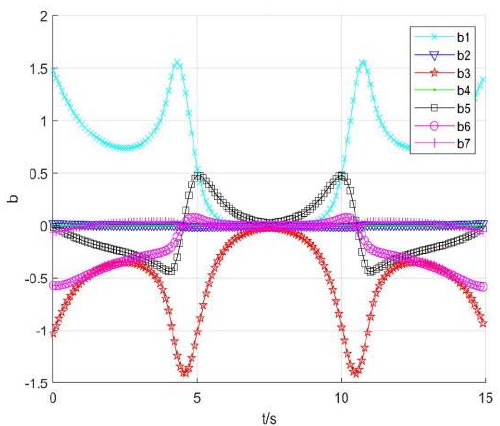
Figure 15. Robot end speed change.